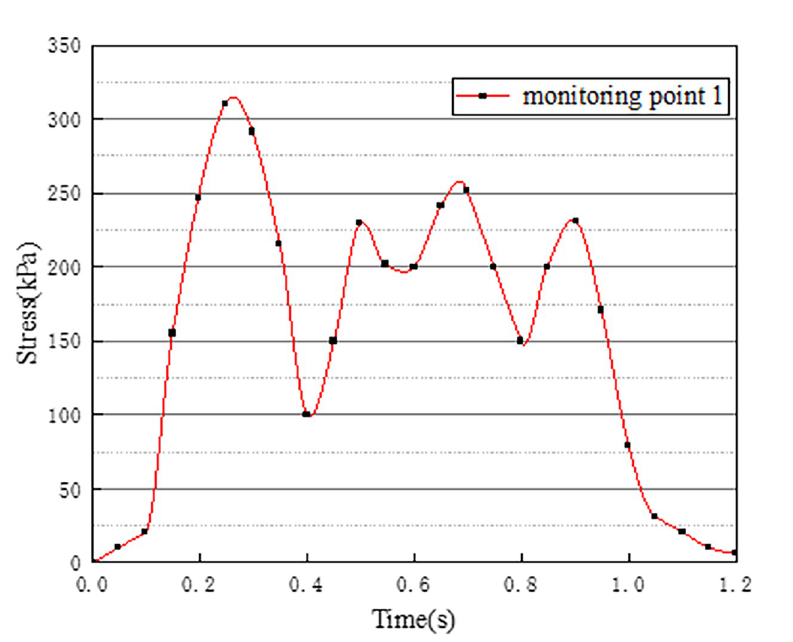
Fig 11. Stress time history curve of monitoring point